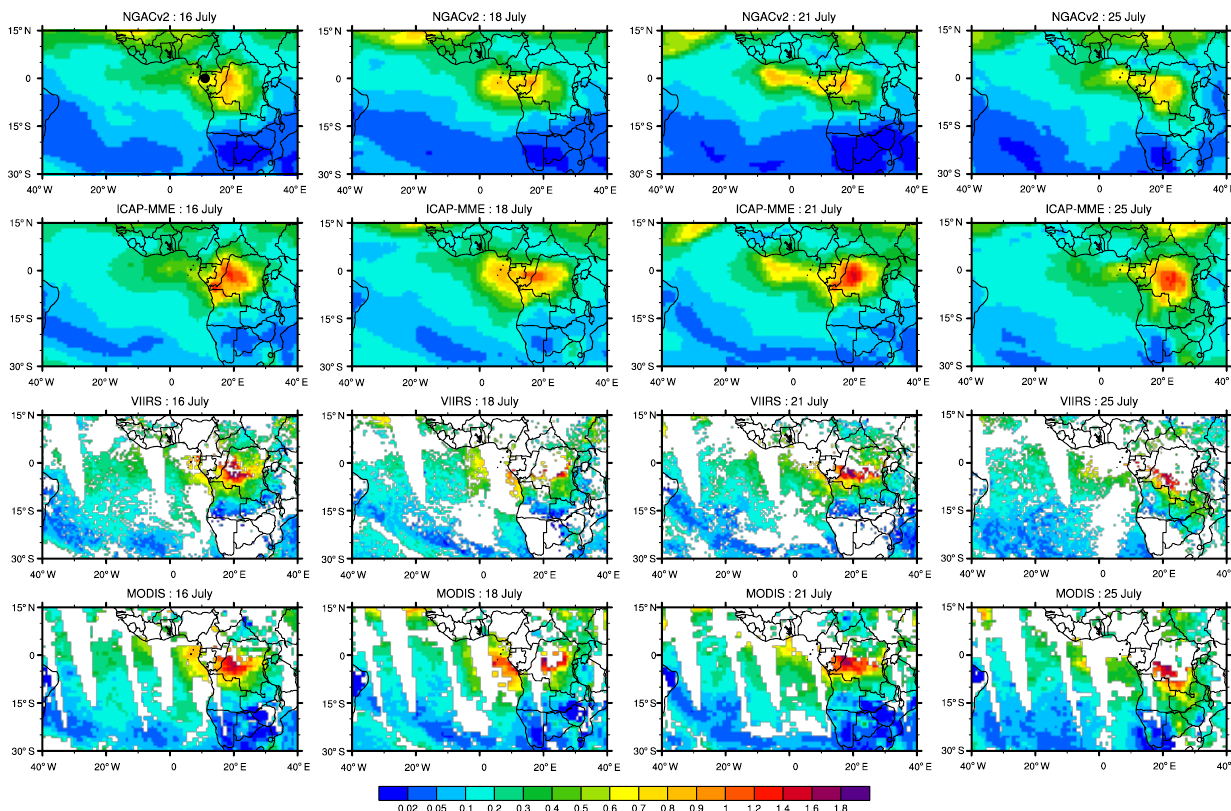
Figure 9. Comparison of total AOD between forecasts of NGACv2 and ICAP-MME to observations of VIIRS and MODIS for selected days in July 2016. For both models, daily 6-hourly forecasts are averaged to compare them to daily satellite observations for each day. Apart from VIIRS, which is at 0.25 ◦ resolution, all others are at 1 ◦ . Satellite observations have data gaps, which are in white (third and fourth rows). The black dot in the first panel represents the approximate location of AERONET station